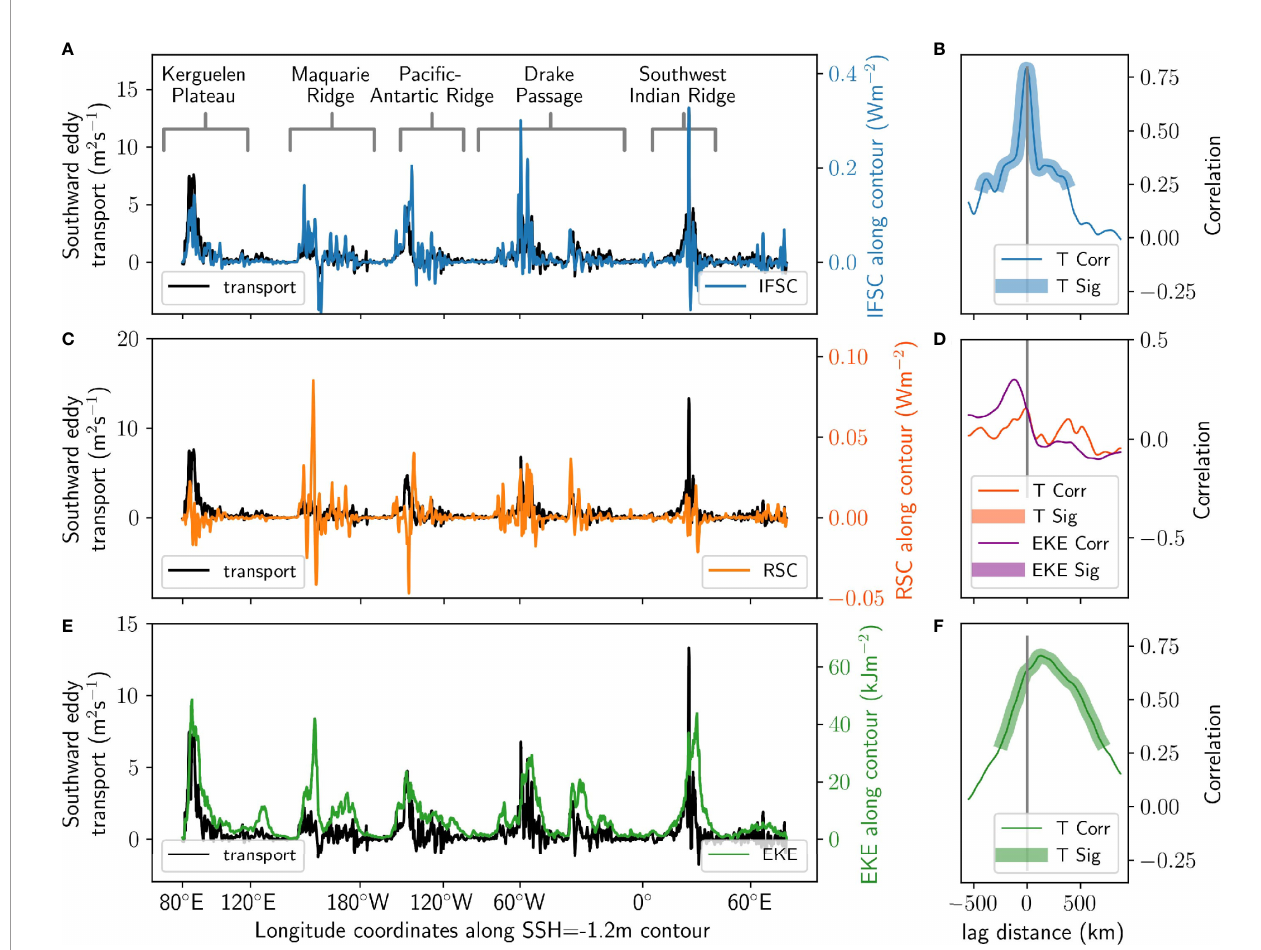
FIGURE 10 | Southward eddy transport vertically integrated over the upwelling arm (black, T) compared with (A) the interfacial form stress energy conversion (IFSC), (C) eddy kinetic energy and (E) Reynolds stress energy conversion (RSC) along the -1.2 m SSH contour. The spatial lag correlations are shown in the right panels (B, D, F) , with highlighting indicating signi fi cant correlations with 95% con fi dence. A correlation peaking at a positive lag distance means the eddy transport (indicated by T, or in the case of the purple line, eddy kinetic energy indicated by EKE) is upstream of the energy term. The additional purple line in panel (D) , the eddy kinetic energy lag distance, compares the eddy kinetic energy and Reynolds stress conversion, where a positive lag indicates the eddy kinetic energy leads the Reynolds stress conversion. Note the change in sign of the eddy transport axes compared to previous analyses, for improved visualisation of the